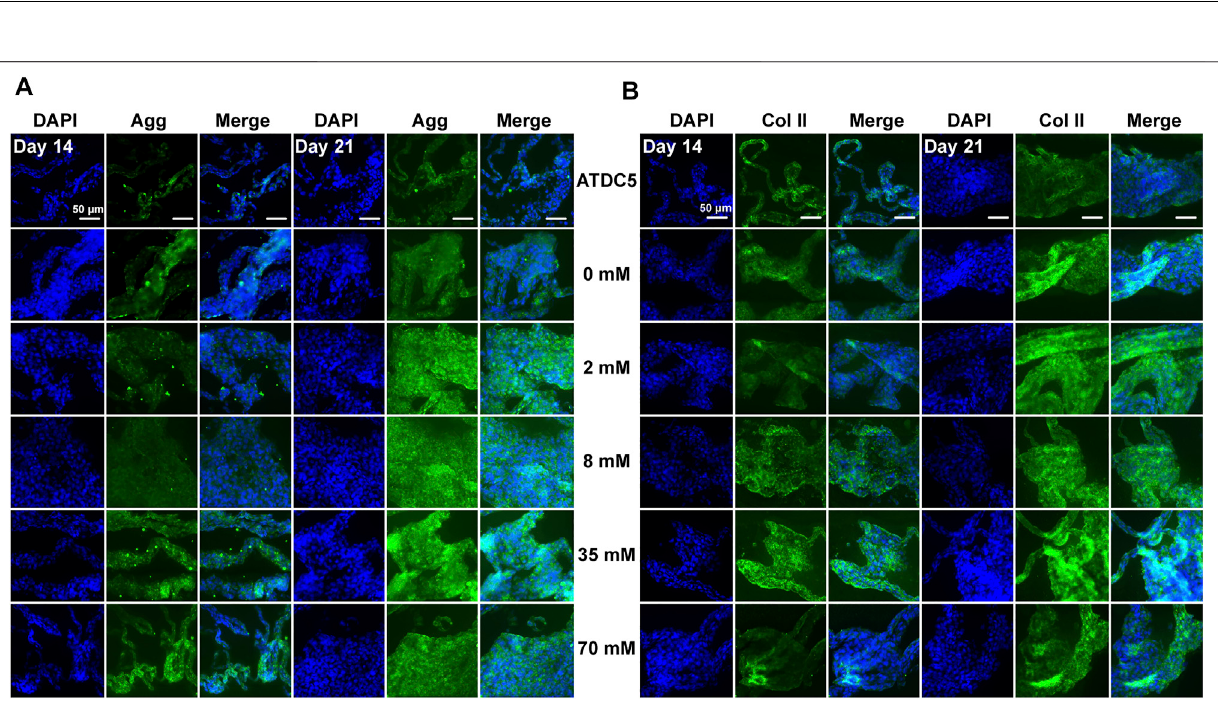
Frontiers in Molecular Biosciences |